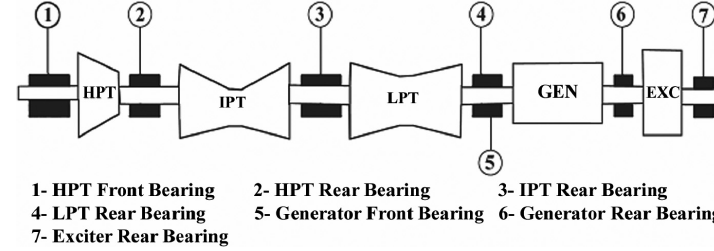
Fig. 1. Turbo Generator line diagram.